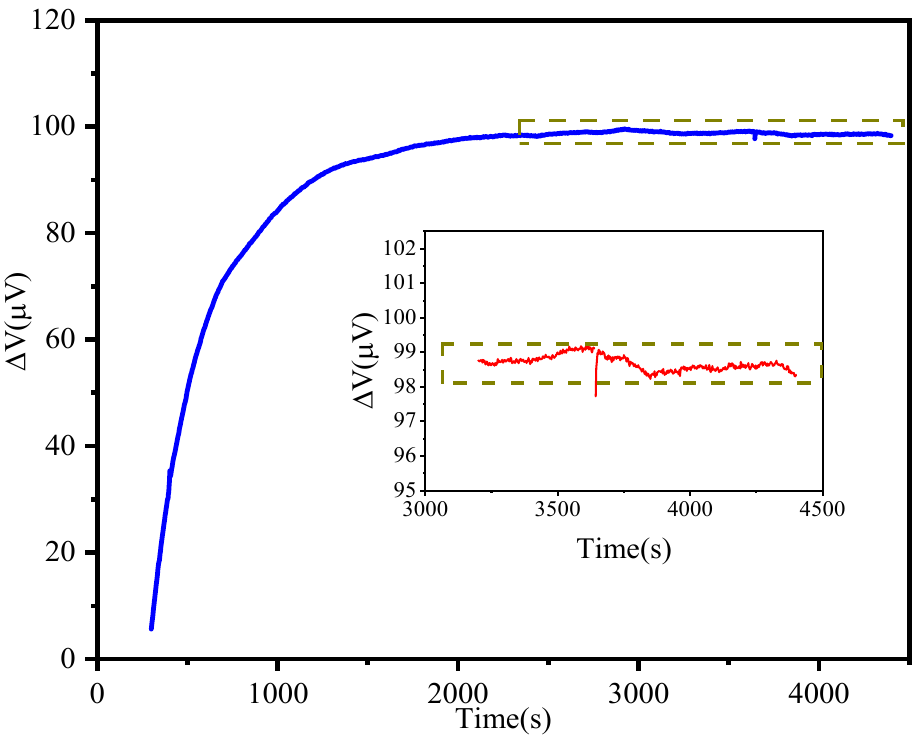
Figure 7. The stability measurement result of the microcantilever in PBS buffer with 3 V bias voltage. Inset is a y ‐ coordinated enlarged figure, the output voltage fluctuation is between 98 and 99 μ V.